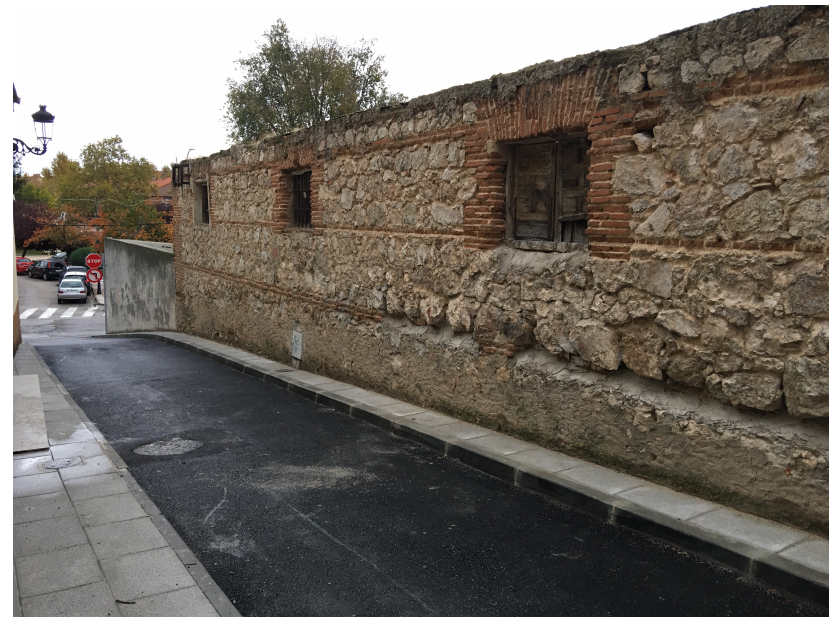
Figure 3. The historic wall object of the field